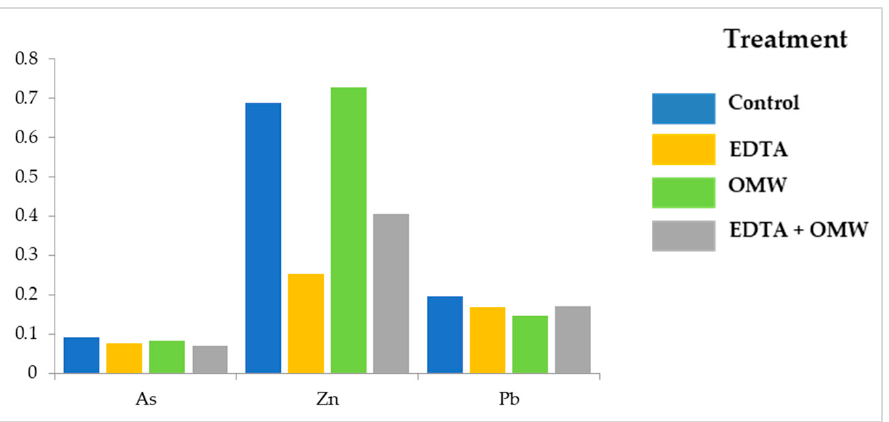
Figure 2. Roots-to-shoots translocation factor (TF) of H. annuus for As, Zn and Pb for different treat- ments. OMW: olive mill